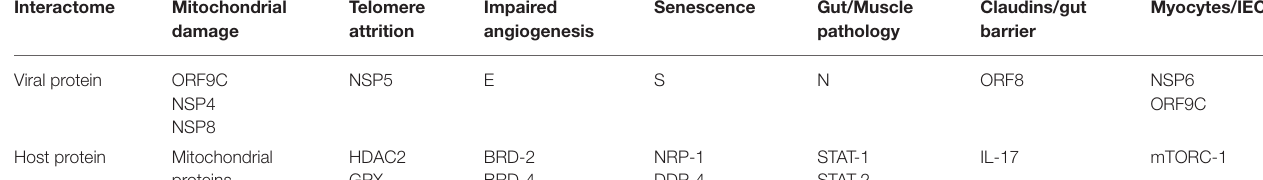
TABLE 1 | Angiotensin II independent changes: viral antigens interact directly with host proteins, altering several senescence pathways, including the metabolism (mitochondrial damage), telomeres and angiogenesis that disrupt biological barriers and immunity, likely contributing to ME/CFS. Interactome